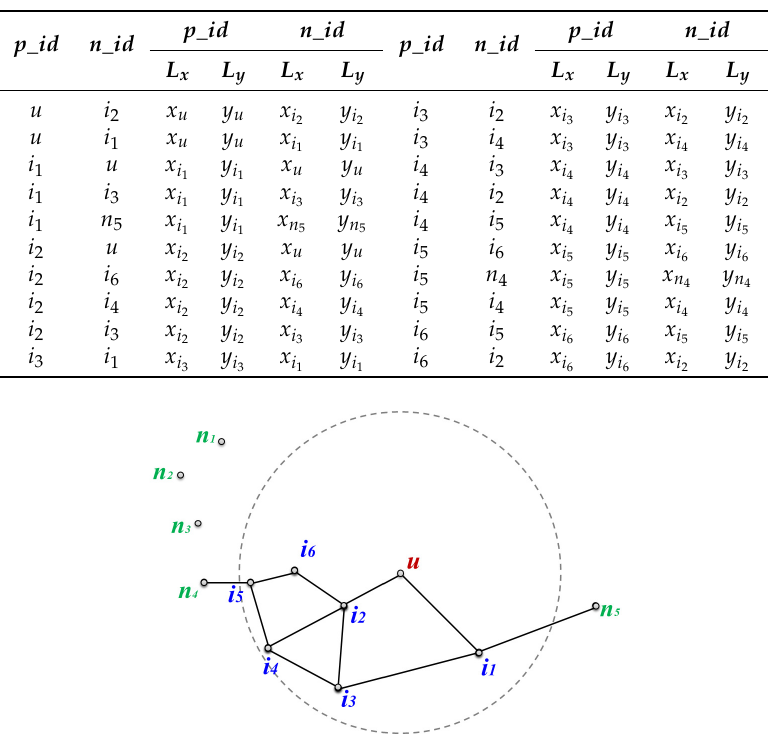
Table 3. The GG full edge list of node u within radio range in Figure 3.